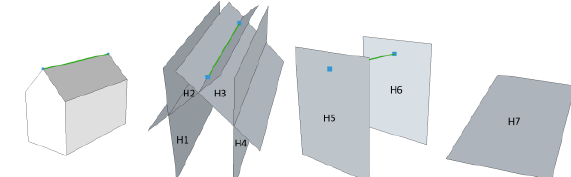
Figure 2. Pitched roof building with a ridge (green line) and two gable features (blue dots), and corresponding